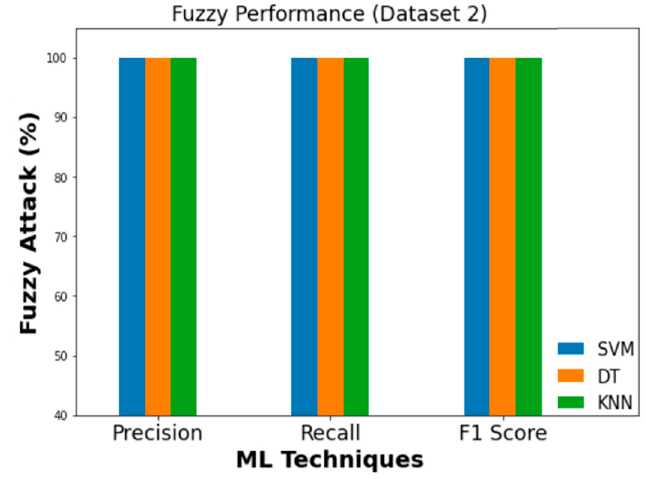
Figure 20. Performance evaluation metrics (fuzzy).